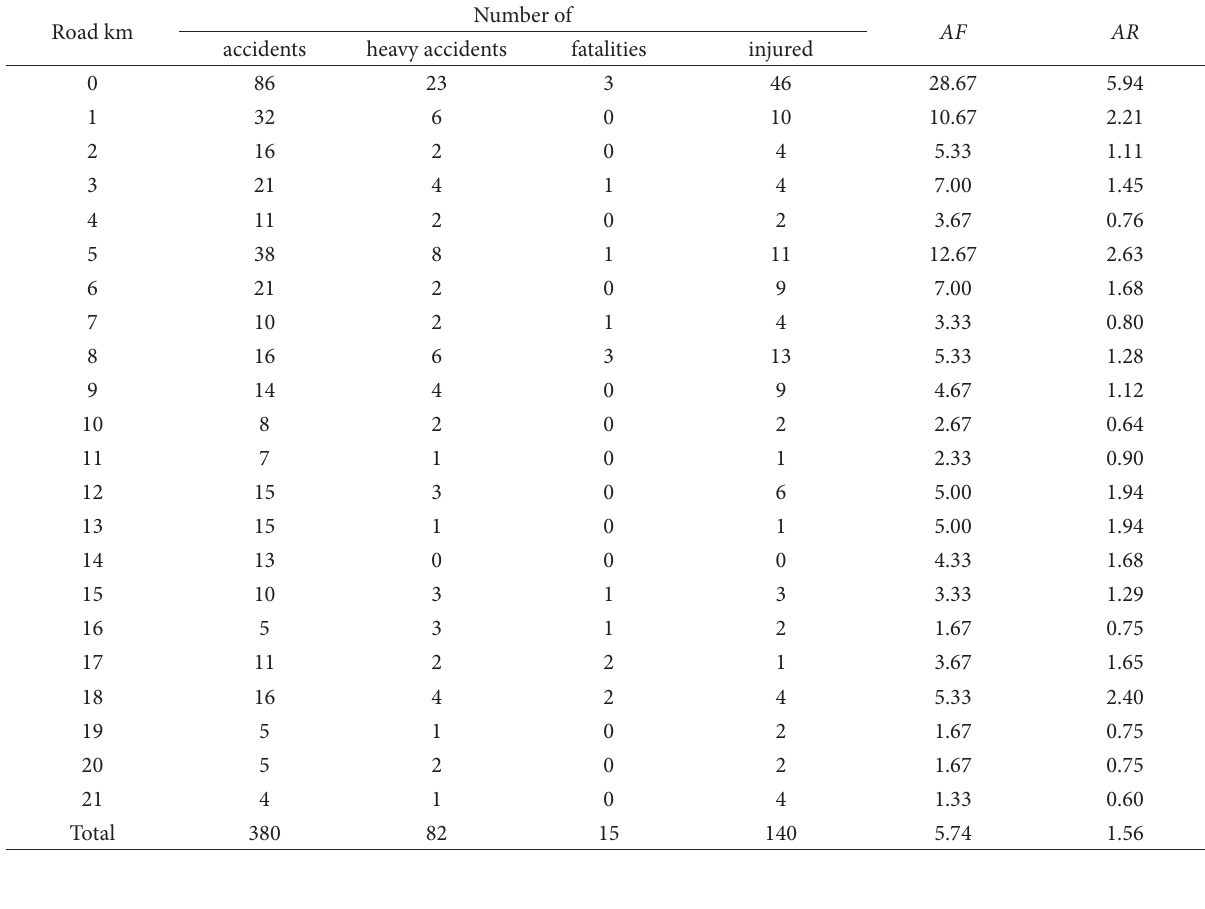
Table 2. Analysis of road traffic accidents on road A4 in 2005–2007 Road km